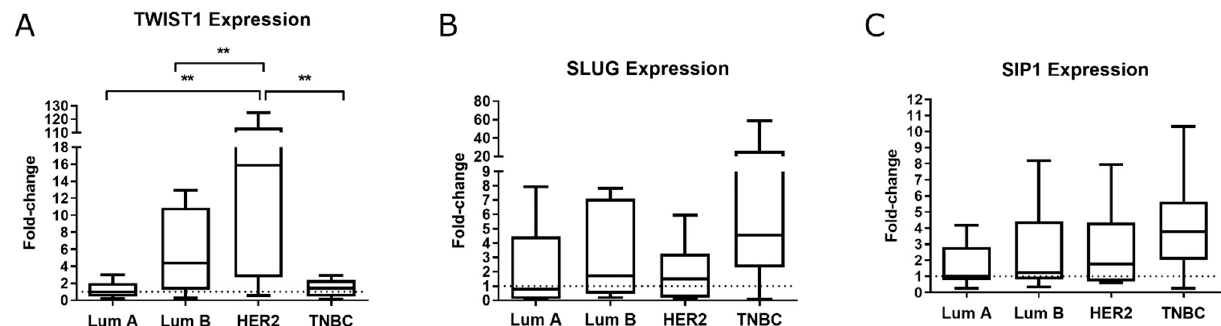
Figure 1. Box-plot graph of TWIST1 ( A ) , SLUG/SNAIL2 ( B ) and SIP1/ZEB2 ( C ) expression (fold-change) in the BC subtypes Luminal A (Lum A), Luminal B (Lum B), HER2+ and Triple-negative (TNBC) from the Brazilian National Cancer Institute cohort. Data are shown as the median ( ± SD). ** p < 0.01.